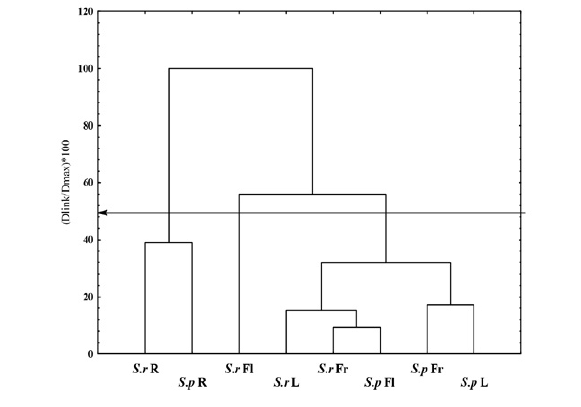
Figure 5. Dendrogram of macroelements content (Mg, Ca, Na and K) in the leaf, flower, fruit, and root of plant species S. rigidum and S.